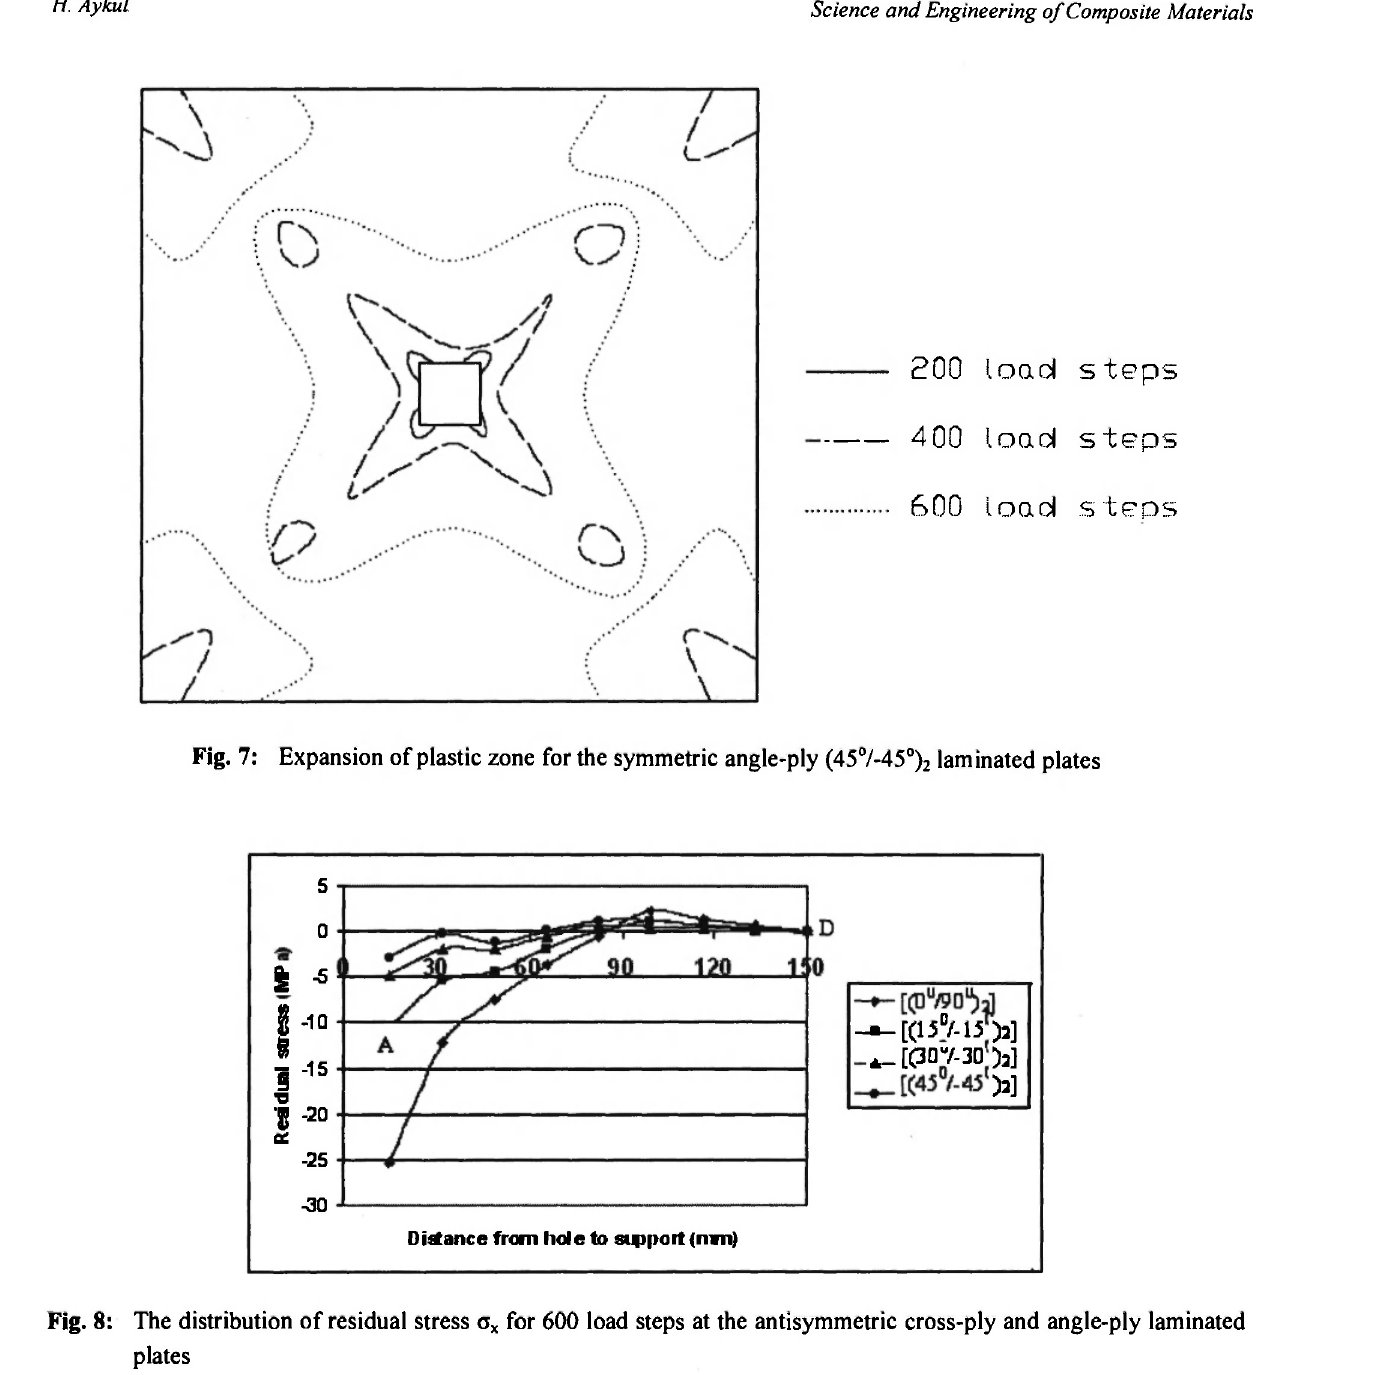
Fig. 8: The distribution of residual stress σ χ for 600 load steps at the antisymmetric cross-ply and angle-ply laminated